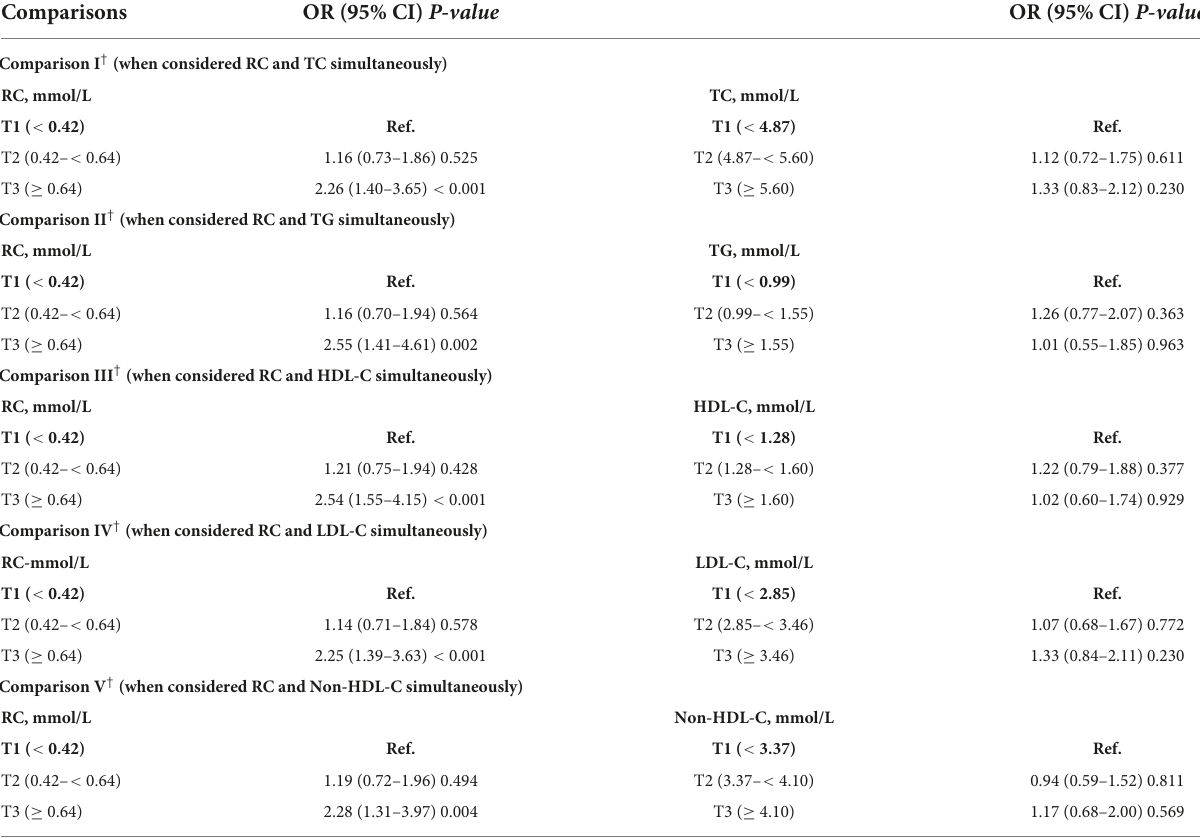
TABLE 3 Comparisons of remnant lipoprotein cholesterol (RC) and another lipid parameter in relation to new-onset carotid